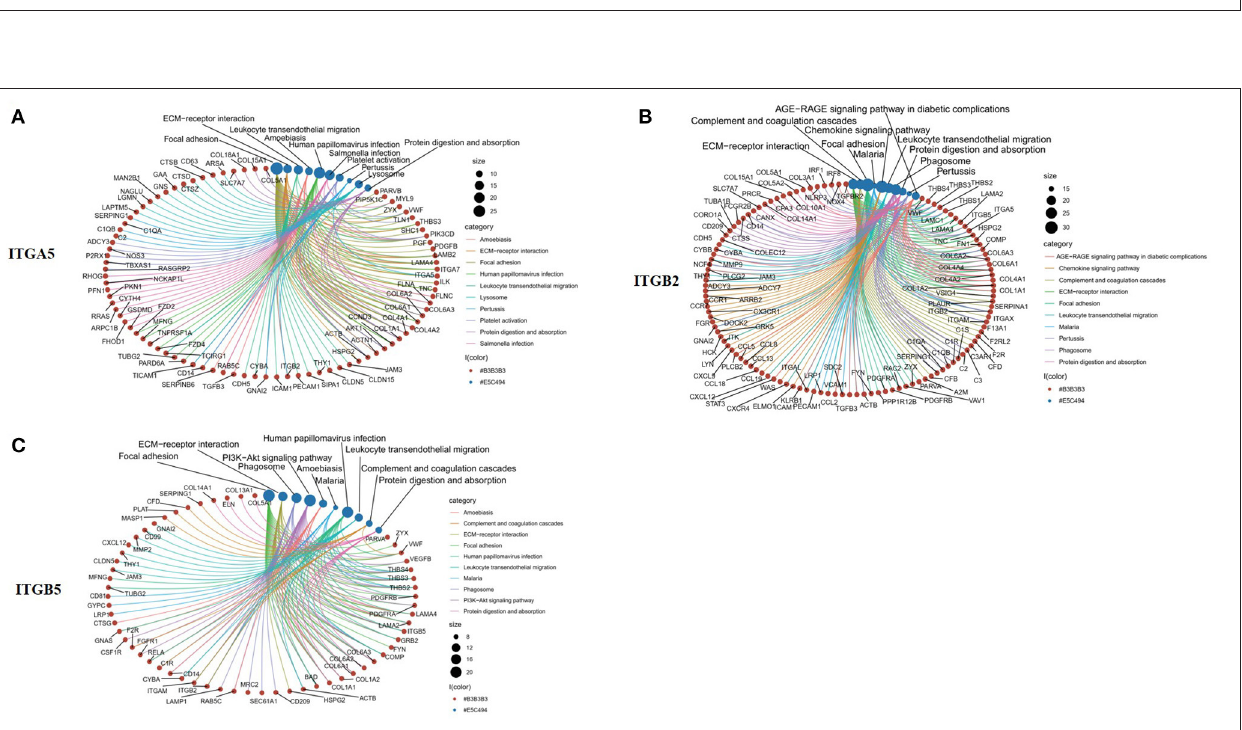
FIGURE 6 | Top 10 significantly enriched KEGG pathway for ITGA5 , ITGB2 , and ITGB5 involved in SSc. (A) ITGA5; (B) ITGB2; (C) ITGB5. The red circle represents genes, and the blue circle represents related signaling pathways enriched by genes. KEGG, Kyoto Encyclopedia of Genes and Genomes; SSc, systemic sclerosis.